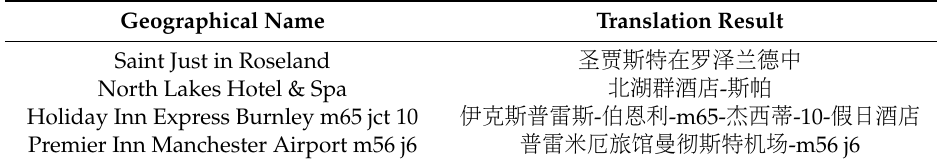
Table 7. Unreliable geographical name translation results